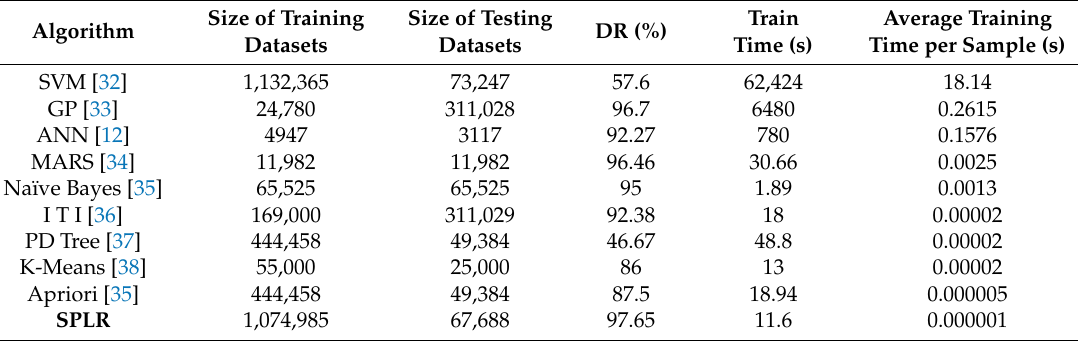
Table 6. Performance Comparison of SPLR with other classifier